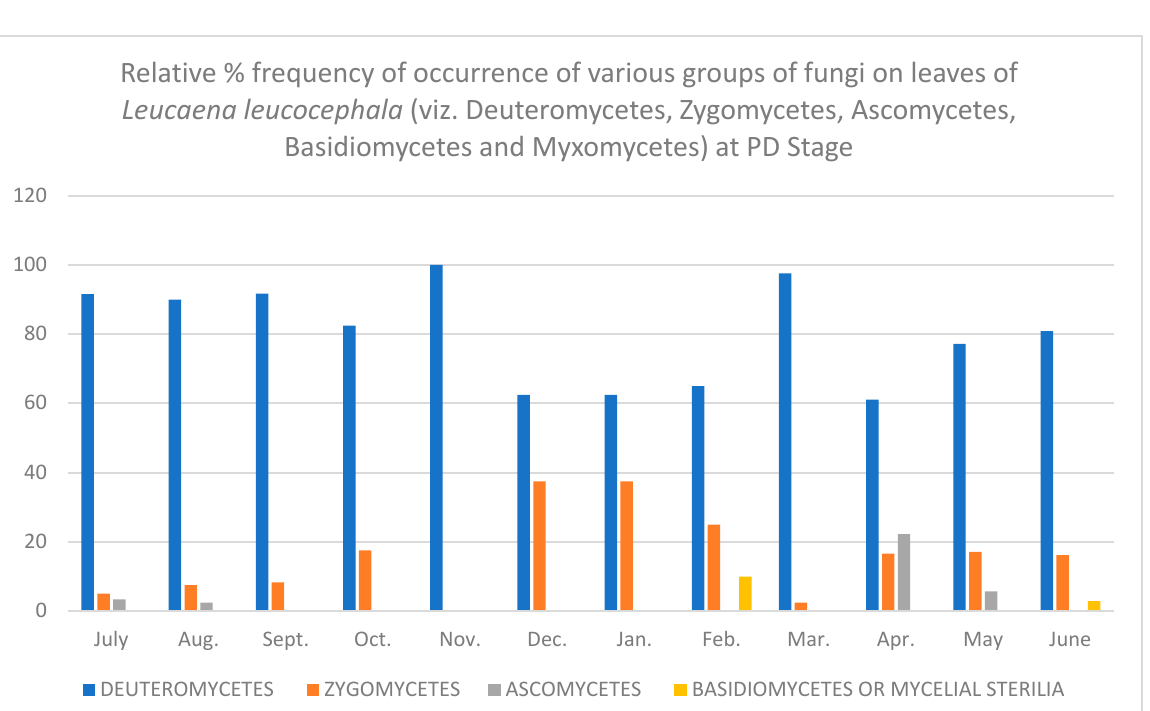
Figure 4. Relative % frequency of occurrence of various groups of fungi on leaves of Leucaena leucocephala (viz. Deuteromycetes, Zygomycetes, Ascomycetes, Basidiomycetes and Myxomycetes) at YF Stage.